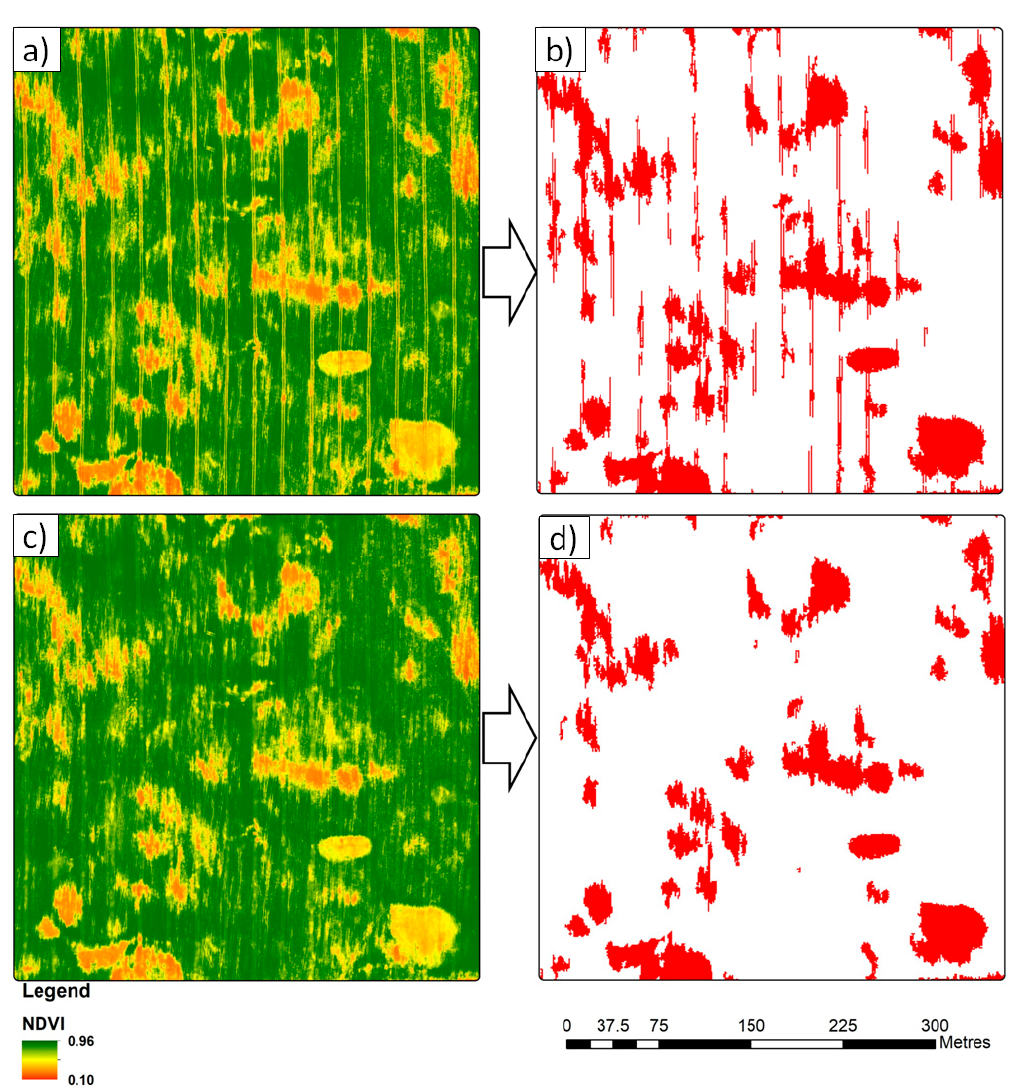
Figure 7. Presentation of impact of tires traces shown on NDVI images and the results of classification of winter damage for crops: ( a ) NDVI image, ( b ) NDVI image after elimination of influence of roads, ( c , d ) the results of classification of winter damages for crop based on the NDVI image, before and after elimination of influence of roads.